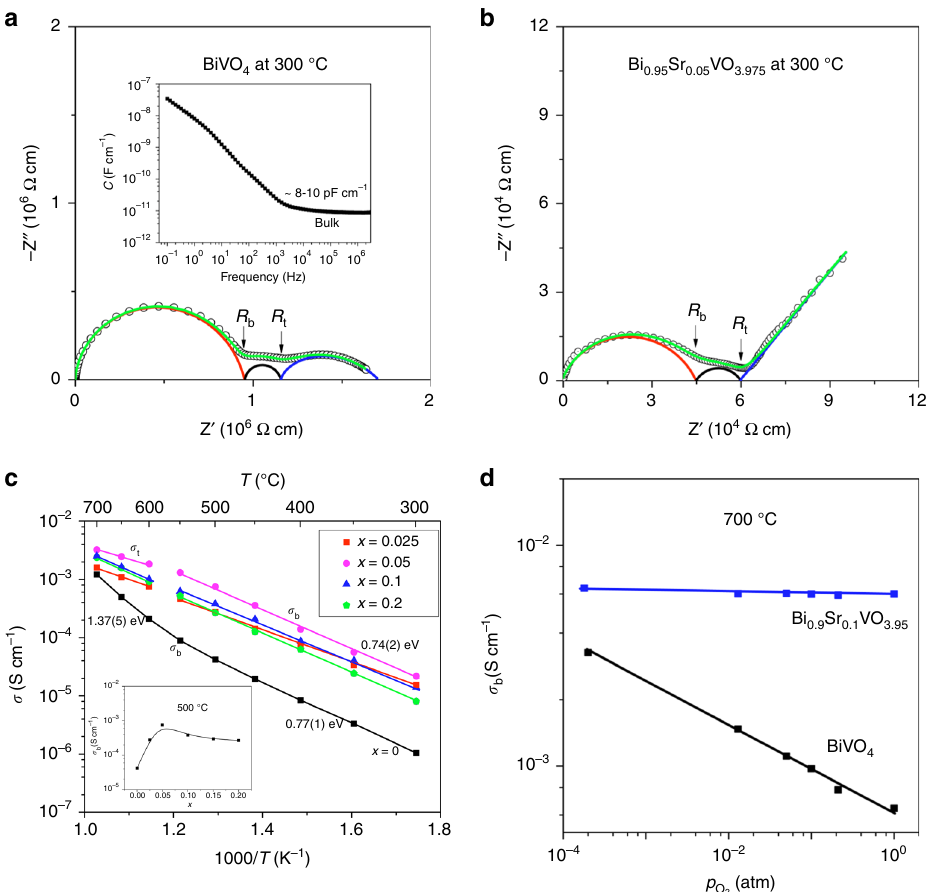
Fig. 5 Ionic conductivity. Typical complex impedance plots at 300 °C of a BiVO 4 and b Bi 0.95 Sr 0.05 VO 3.975 and their fi tted curves (green), as well as the deconvolution of bulk (red), grain boundary (black), and electrode (blue)-response arcs. R b and R t denote bulk and total resistivities, respectively. The inset in a shows the capacitance as a function of frequency. c Arrhenius plots of the conductivities for Bi 1 − x Sr x VO 4 − 0.5 x ( x = 0 – 0.2). The inset shows the bulk conductivity at 500 °C as a function of x . d The p O 2 dependency of the conductivity of BiVO 4 and Bi 0.9 Sr 0.1 VO 3.95 at 700